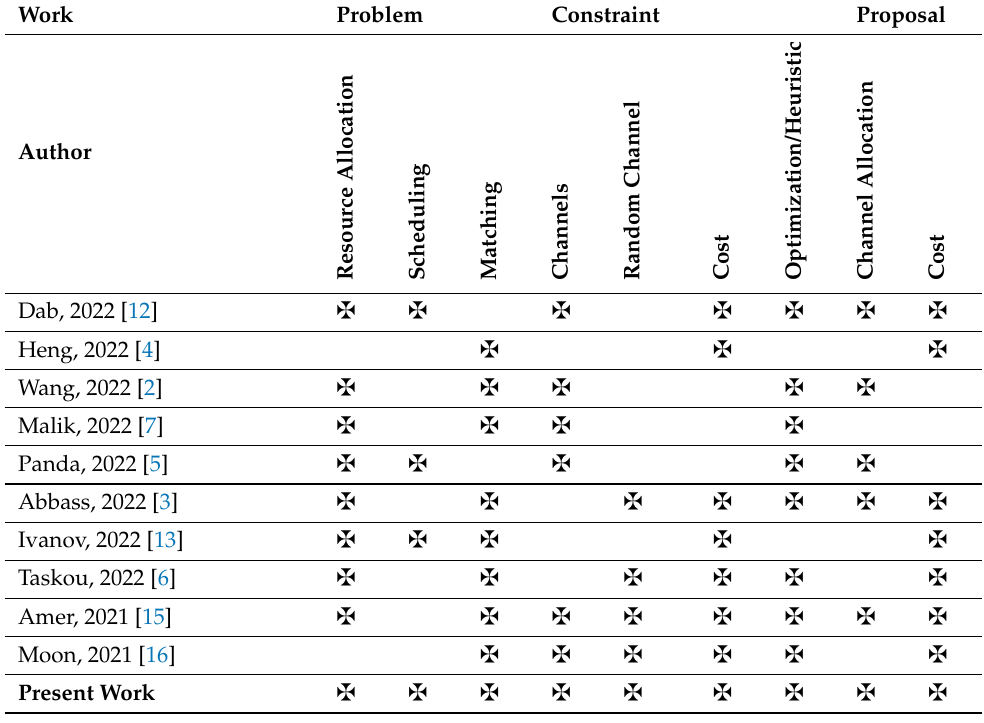
Table 1. Summary of works related to peer instruction and learning engineering. Work